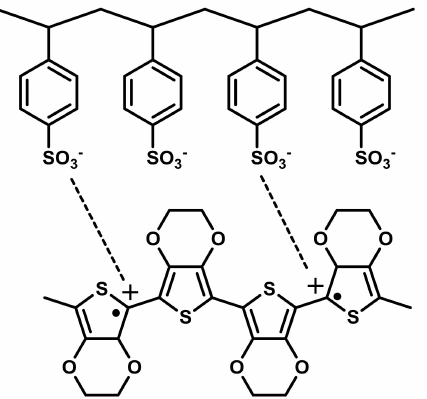
Figure 4. Stabilization of the bipolaron in the PEDOT moiety by the presence of PSS co-polymer